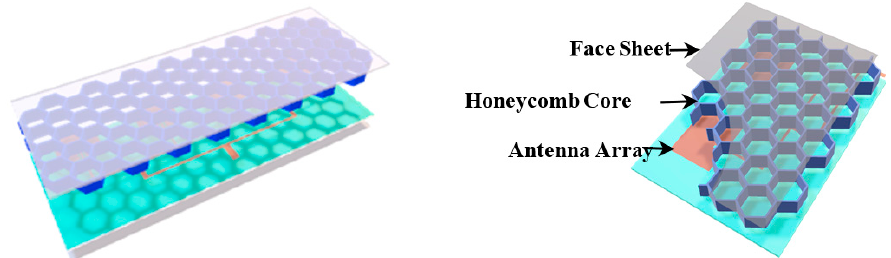
Figure 1. The conventional structure of conformal load-bearing antenna array.